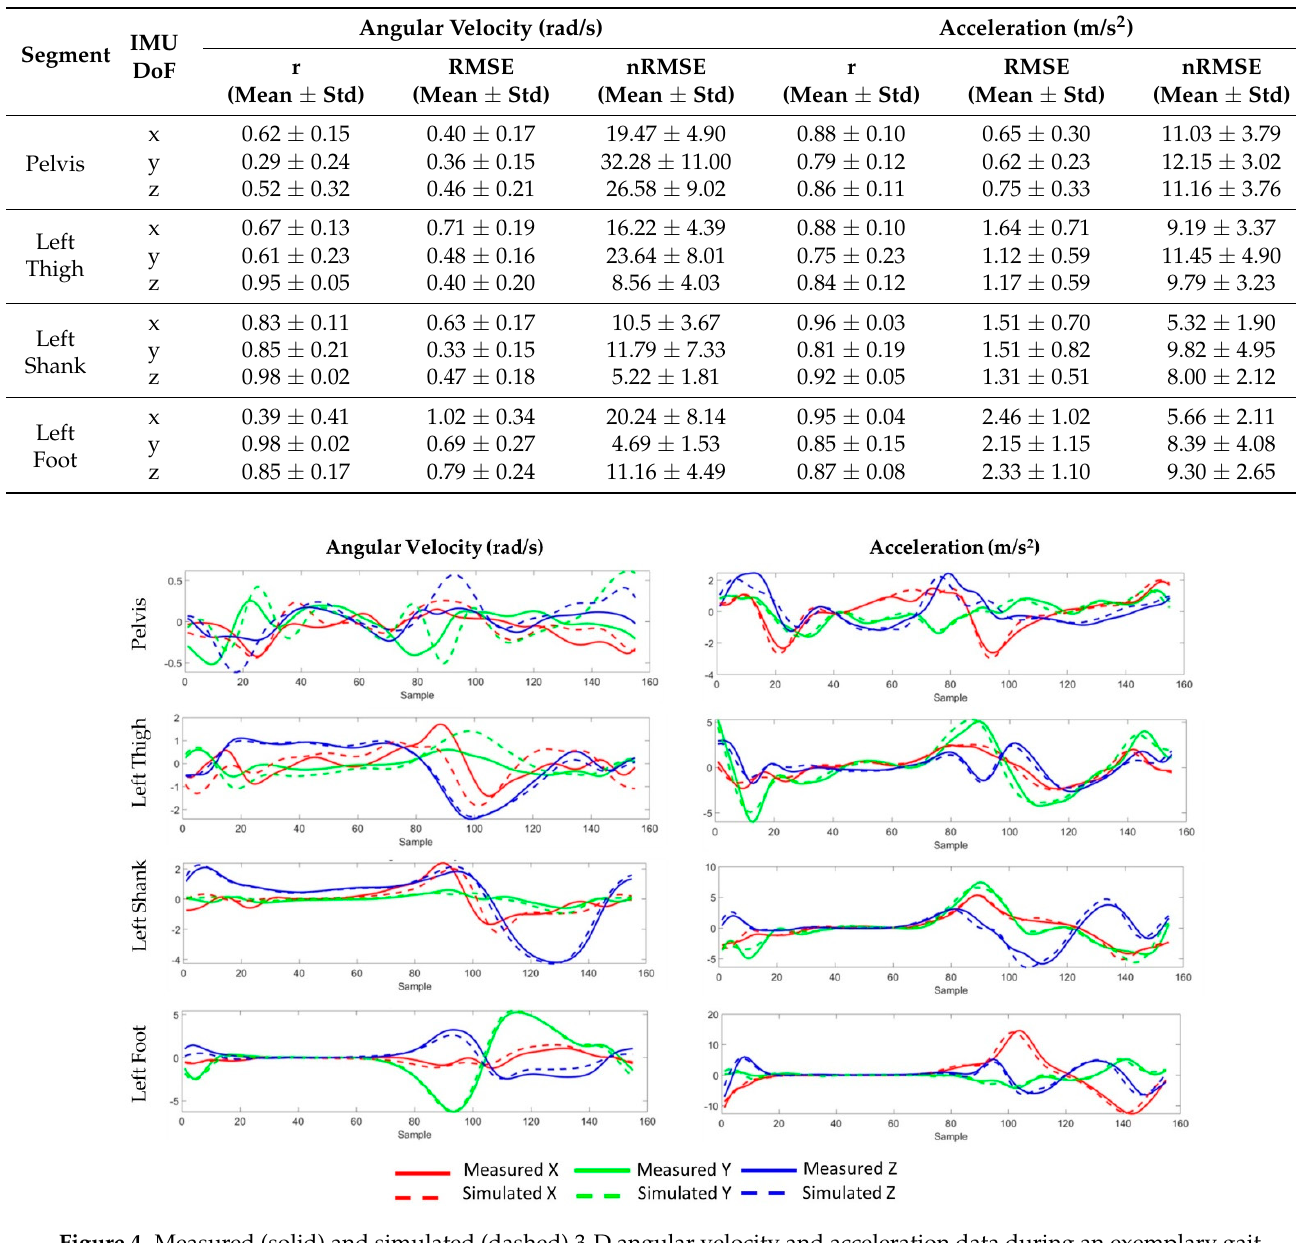
Figure 4. Measured (solid) and simulated (dashed) 3-D angular velocity and acceleration data during an exemplary gait cycle. The IMU sensors were located on the pelvis, the lateral left thigh, the lateral left shank, and on top of the left foot.